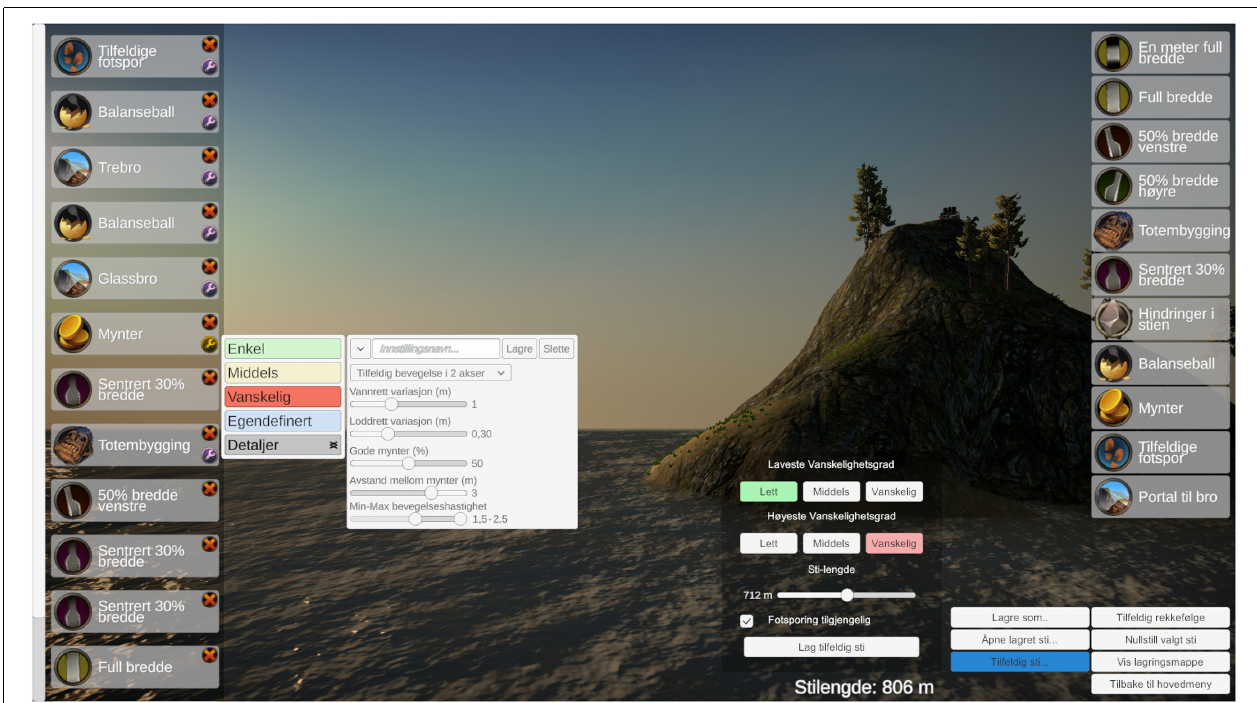
FIGURE 5 | The therapist/operator can access a detailed Path Builder and design individualized tasks and